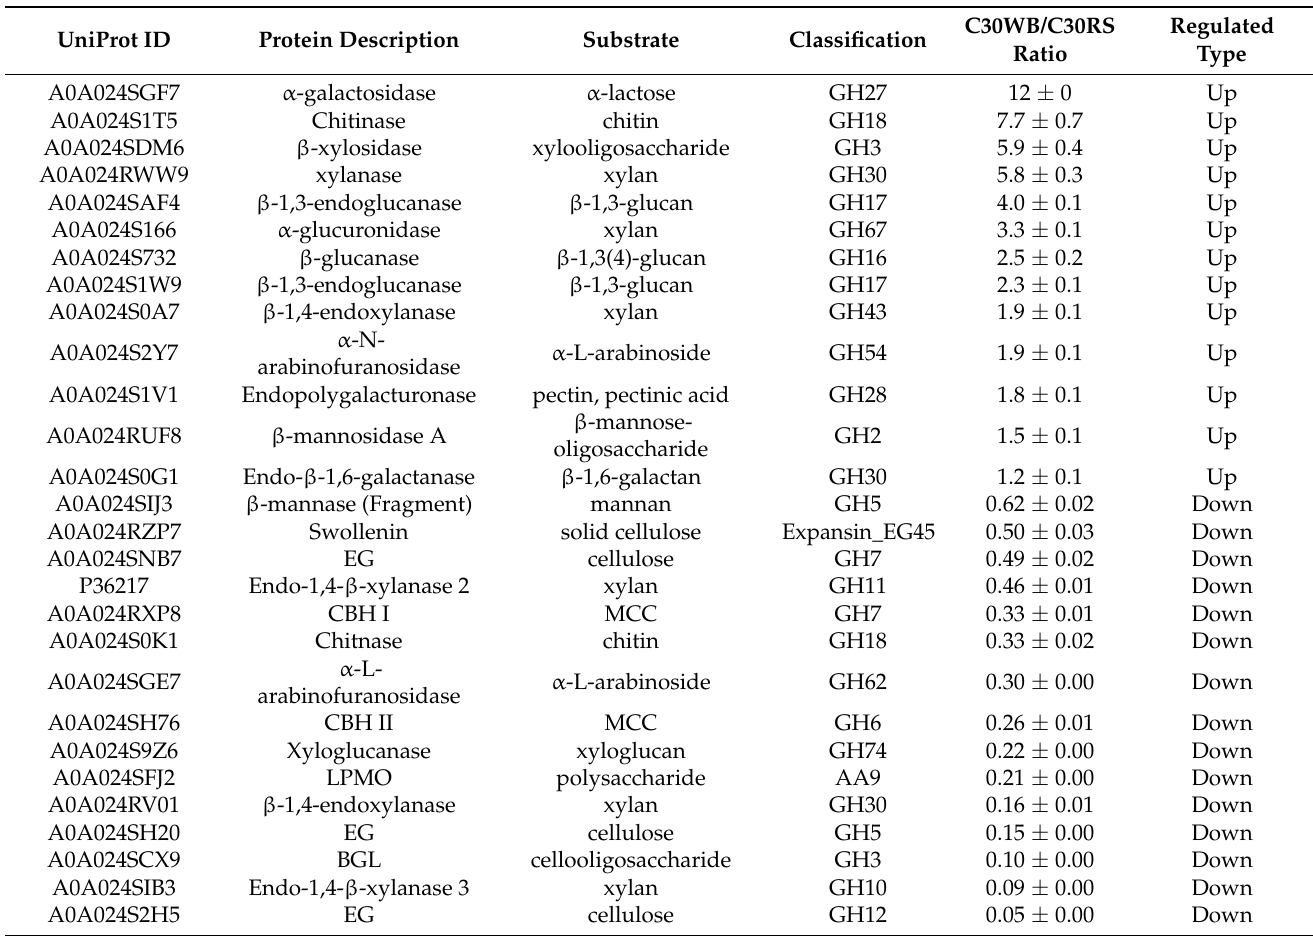
Table 4. The up-regulated and down-regulated proteins of C30WB compared with